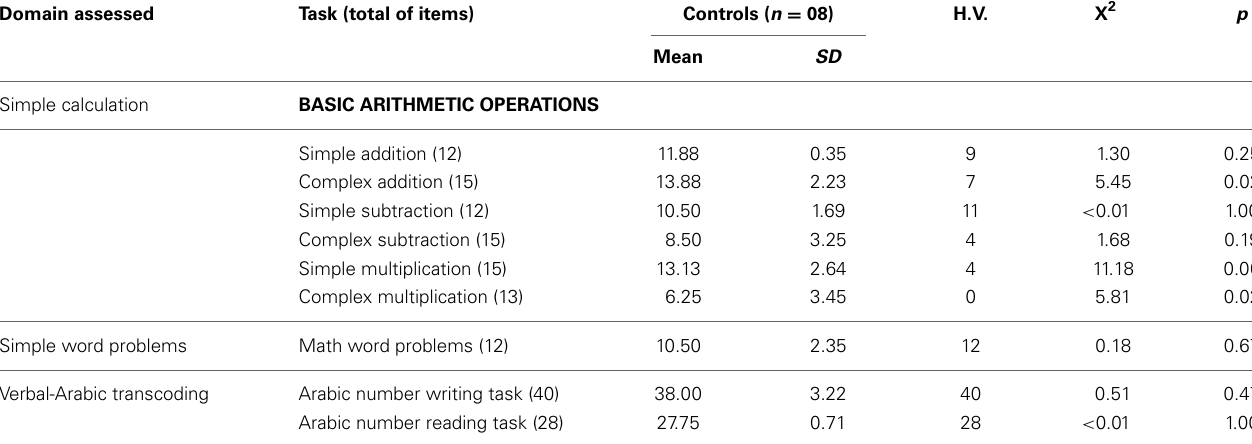
Table 3 | Descriptive data and comparisons between control groups and H.V. in the Simple calculation, Simple word problems, and Verbal-Arabic transcoding tasks ( df = 1).